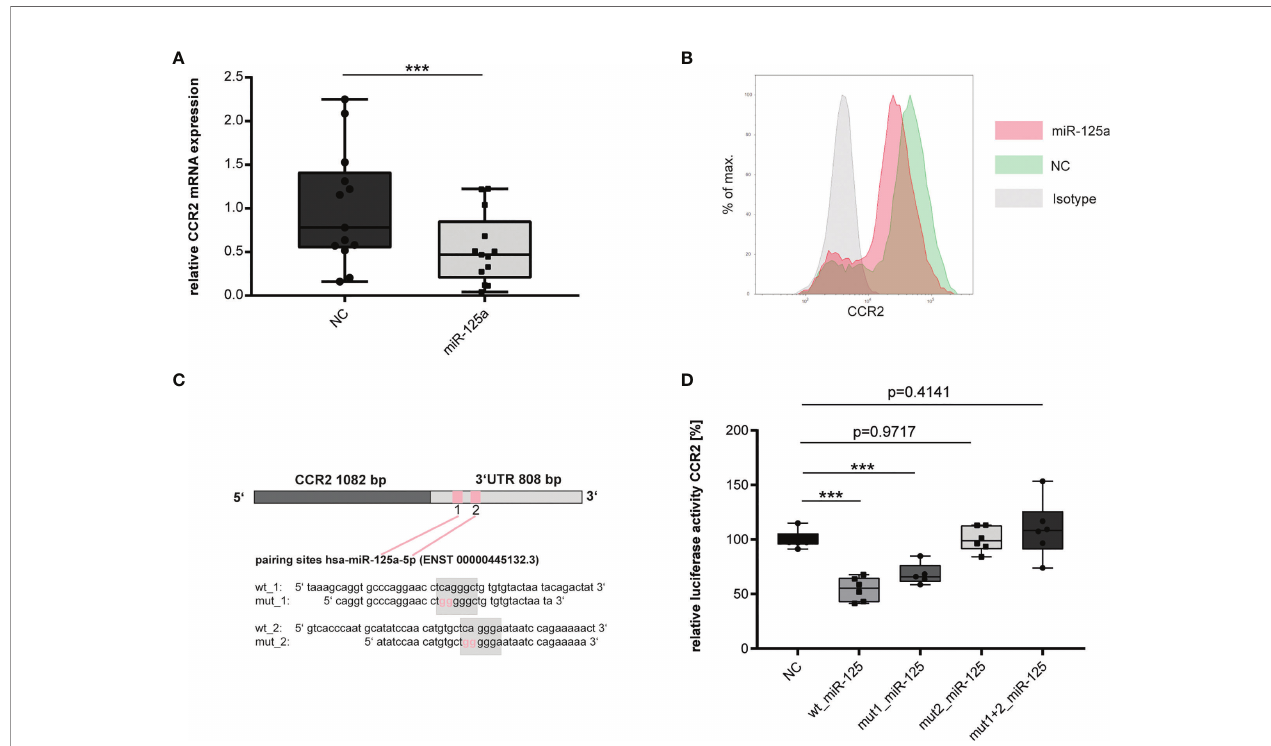
FIGURE 5 | Validation of miR-125a direct target CCR2. (A) mRNA (n=13,***p<0.001) and (B) protein (n=3, one exemplary experiment is shown) expression of CCR2 in primary human monocytes after tranfection of miR-125a or scrambled control (NC). (C) Schematic representation of the two predicted miR-125a binding sites within the 3`UTR of CCR2, including the site-directed oligonucleotide exchanges introduced for luciferase experiments. (D) CCR2 3`UTR Luciferase reporter gene activity after co-transfection of the luciferase constructs with miR-125a or scrambled control (NC). Luciferase constructs: wt_CCR2: both binding sites of miR- 125a in the CCR2 3`UTR are functional; mut1_miR-125a: site-directed mutagenesis of binding site 1; mut2_miR-125a: site-directed mutagenesis of binding site 2; mut1+2_miR-125a: site-directed mutagenesis of both binding sites (n=6,